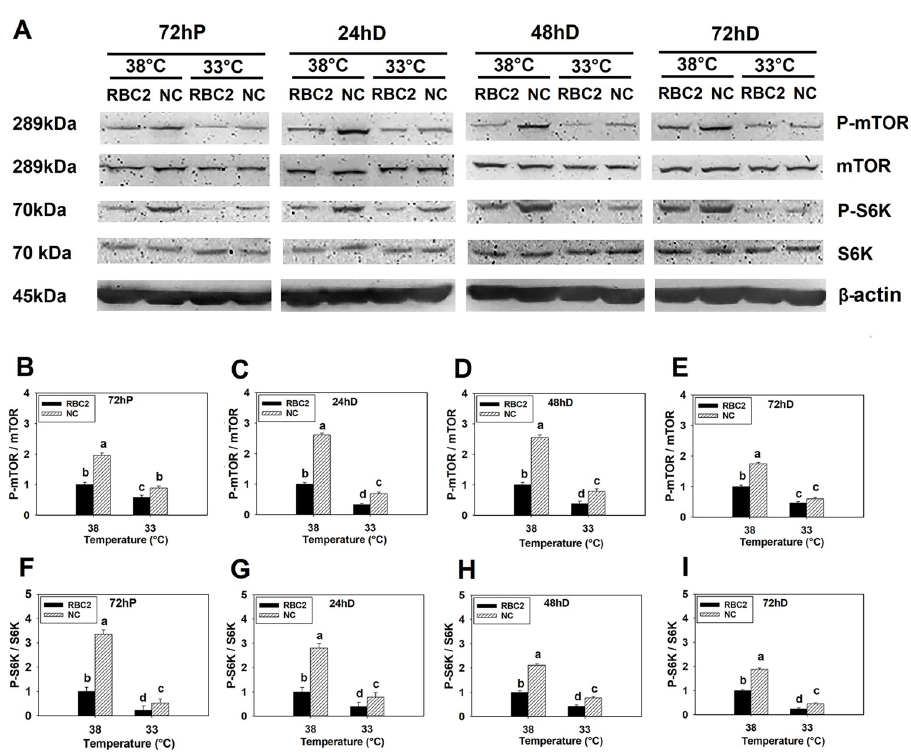
Fig 2. Effect of cold stress on phosphorylation of mTOR and S6K in RBC2 and NC line SCs. (A) Protein levels of the unphosphorylated and phosphorylated forms of mTOR and S6K, and an internal control β -actin in SCs from the RBC2 and NC lines cultured at 38˚ or 33˚C determined by western blot analysis at 72 h of proliferation (72hP) and 24 h (24hD), 48 h (48hD), and 72 h (72hD) of differentiation. Molecular weight and name of each target protein is shown on the left and right side of each figure, respectively. The densitometric ratio of phosphorylated to unphosphorylated mTOR was analyzed in each treatment group at 72hP (B), 24hD (C), 48hD (D), and 72hD (E). The densitometric ratio of phosphorylated to unphosphorylated S6K was analyzed in each treatment group at 72hP (F), 24hD (G), 48hD (H), and 72hD (I). Each graph bar represents a mean ratio, and each error bar represents a standard error of the mean value. Mean values with different letters are significantly different ( P �